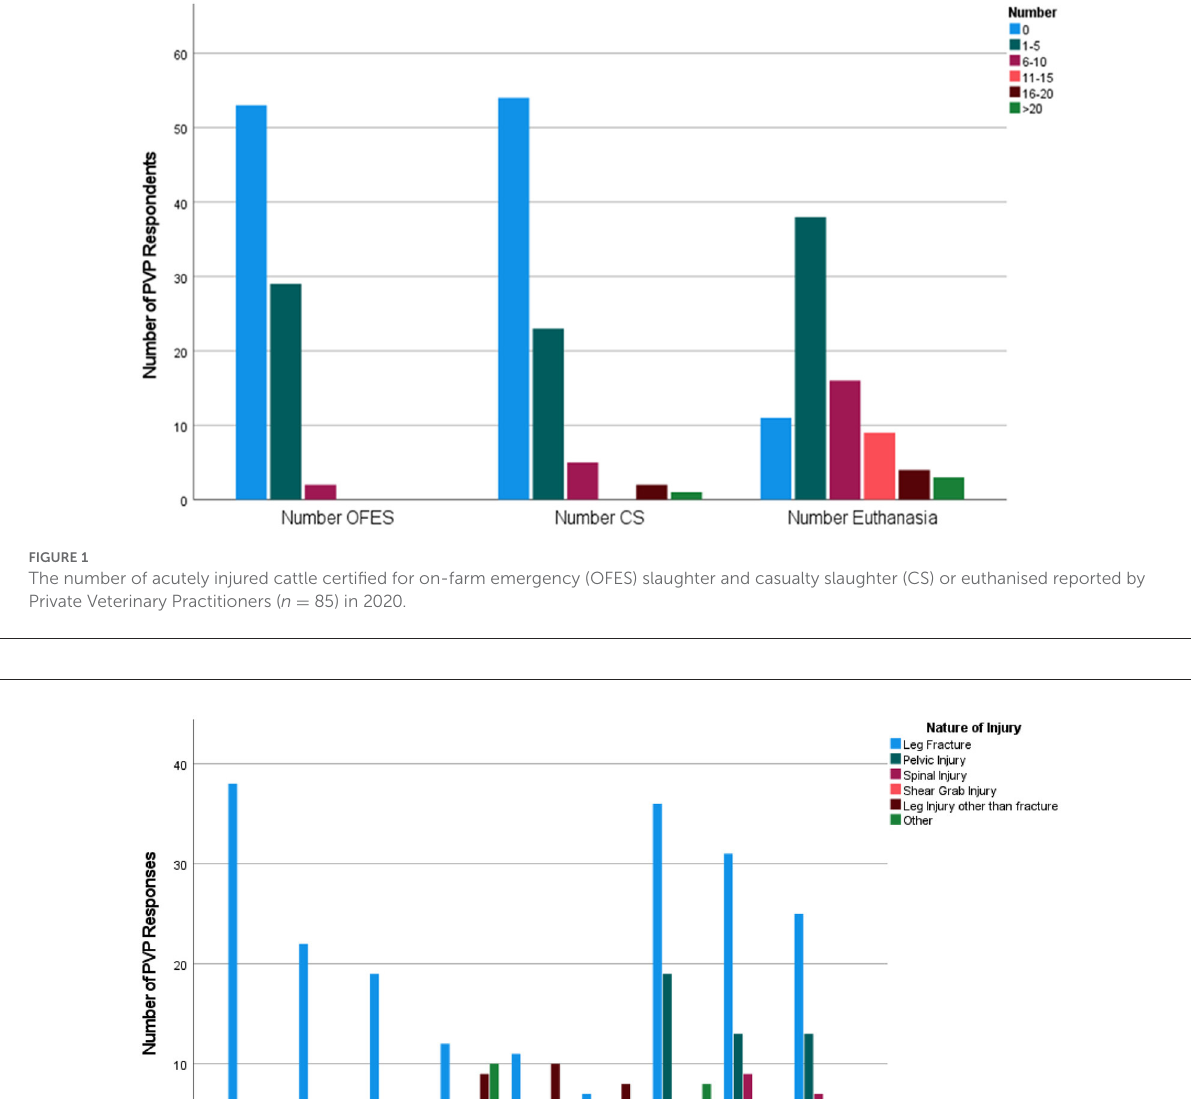
transport or during unsuccessful rehabilitation on the farm but in contrast, other participants believed that OFES is negative